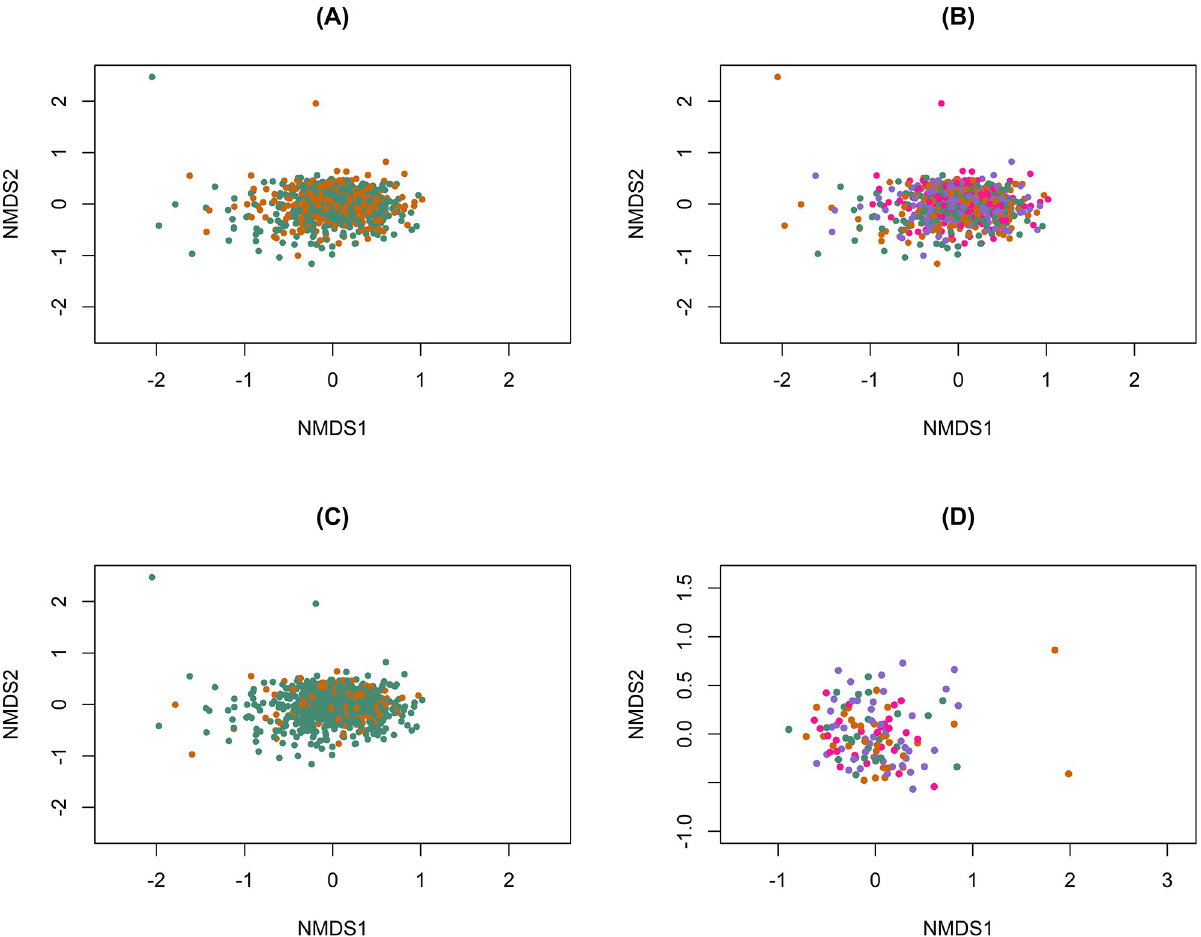
Fig 2. Bray-Curtis dissimilarity distances, colored by measures of physical activity. (A) Bray-Curtis dissimilarity distances, colored by physically active status. PERMANOVA R 2 = 0.004 ( P = 0.001). SHOW, 2016–2017. (B) Bray-Curtis dissimilarity distances, colored by quartile of MVPA minutes per week. PERMANOVA R 2 = 0.003 ( P = 0.001). SHOW, 2016–2017. (C) Bray-Curtis dissimilarity distances colored by engagement in any active transportation. R 2 = 0.003 ( P = 0.009). SHOW, 2016–2017. (D) Bray-Curtis dissimilarity distances, colored by quartile of minutes in active transportation per week, excluding participants who reported no active transportation (n = 147). PERMANOVA R 2 = 0.004 ( P = 0.92). SHOW, 2016– 2017.